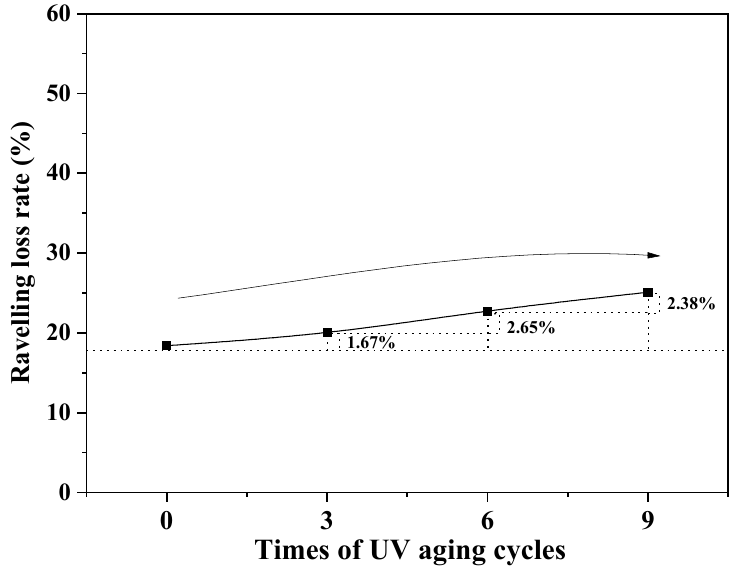
Figure 5. Effect of the UV aging cycle test on the ravelling resistance performance of asphalt mix- tures.